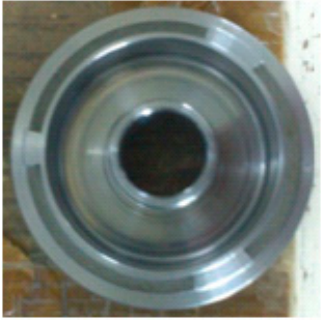
Figure 1. Automotive component used in the study.